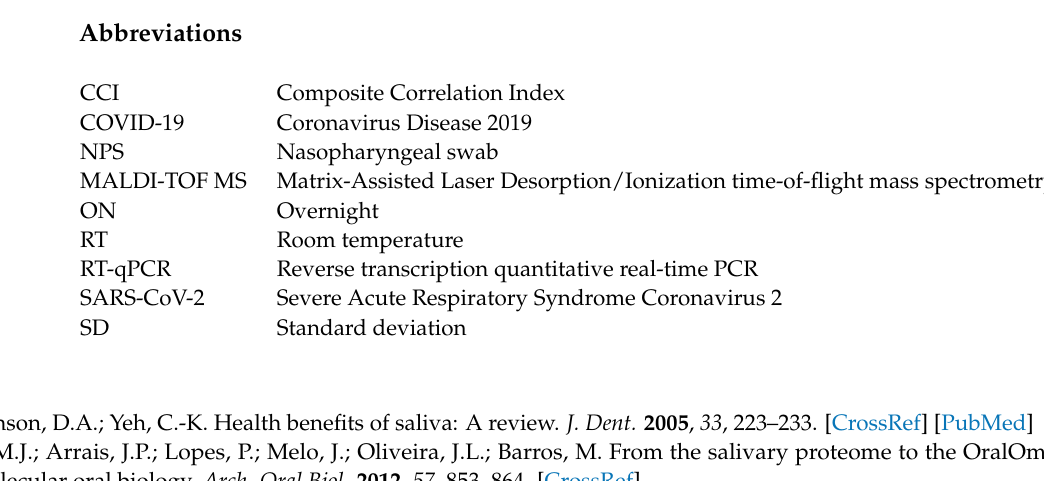
workers, Figure S2: Effect of daily storing on stability of salivary MS profiles, Figure S3: Stability of saliva MS profiles from same individuals along one